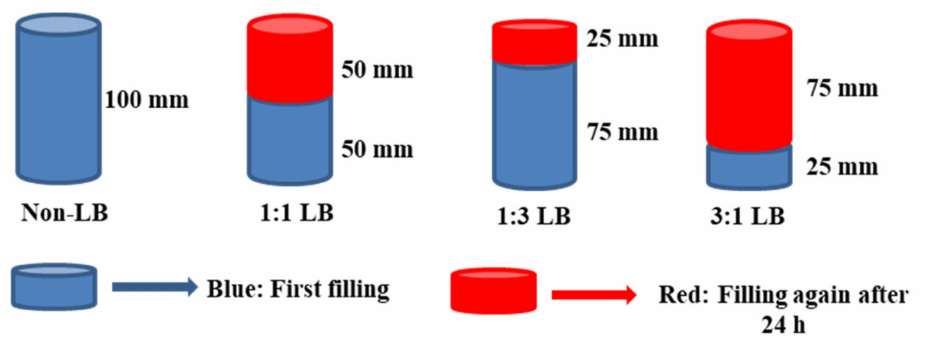
Figure 4. Diagram of preparation sequence of stratified and unstratified